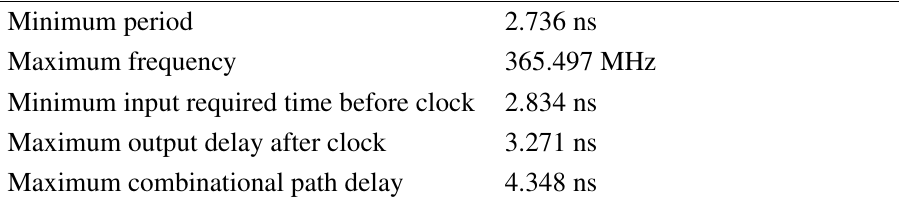
Table 3. Temporal results for the 8 -AC motion